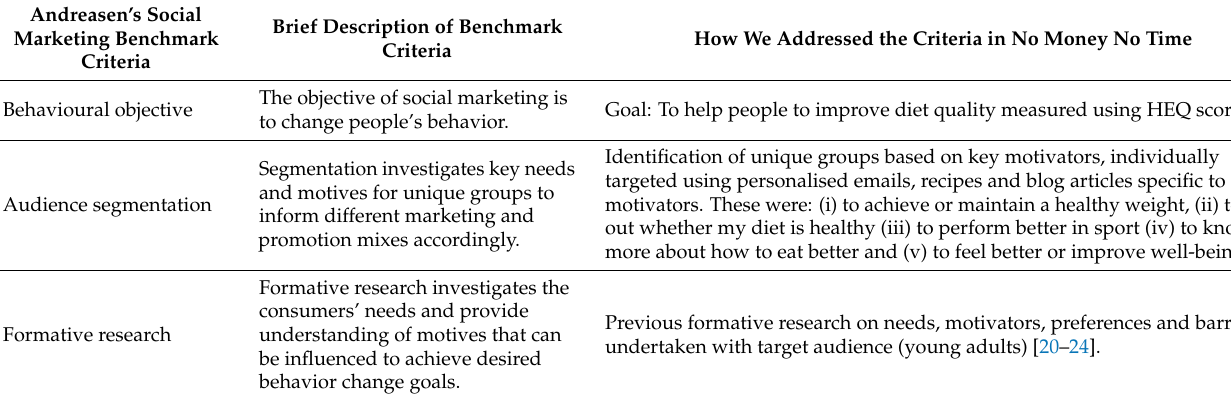
Table 1. Application of Andreasen’s social marketing benchmark criteria [17] in No Money No Time. Andreasen’s Social Brief Description of Benchmark Marketing Benchmark Criteria